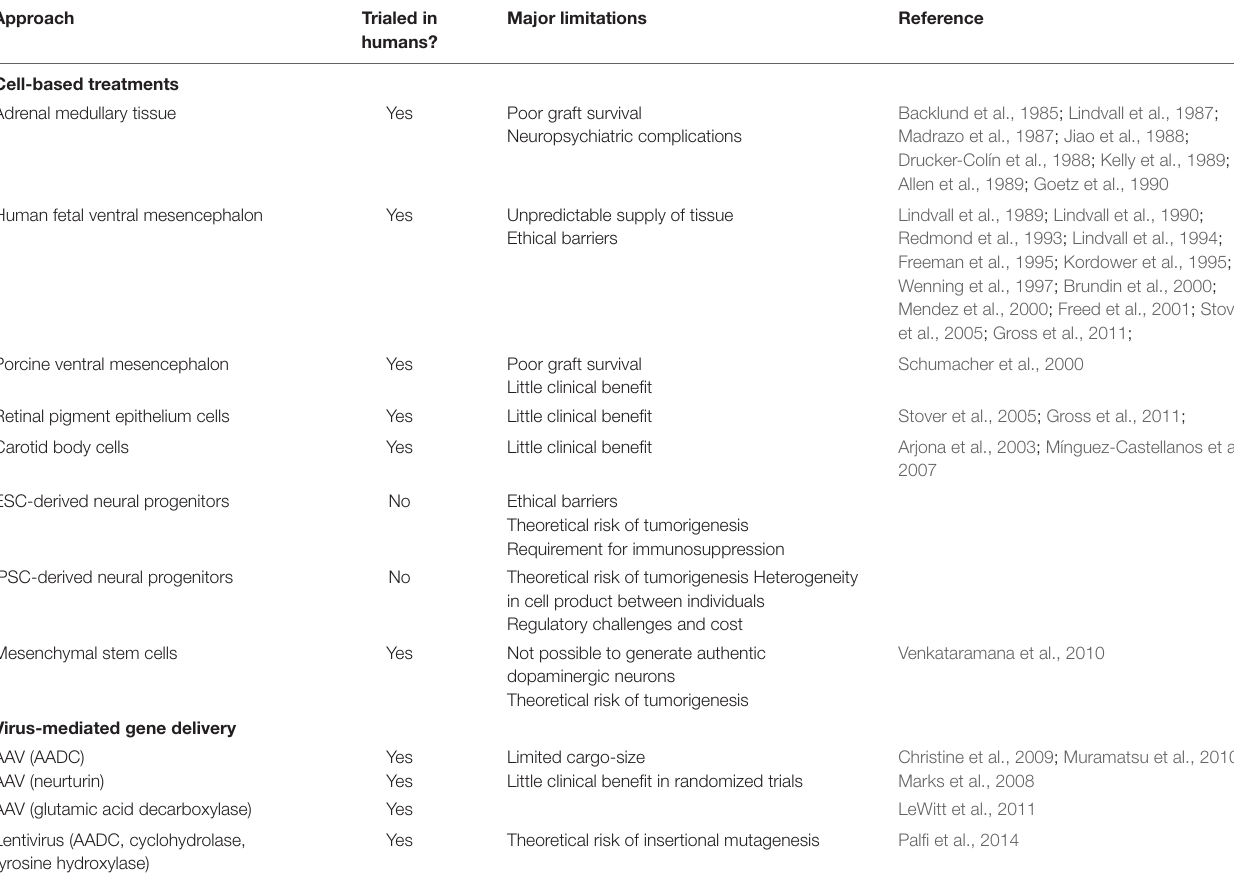
TABLE 1 | Experimental regenerative approaches to treating Parkinson’s